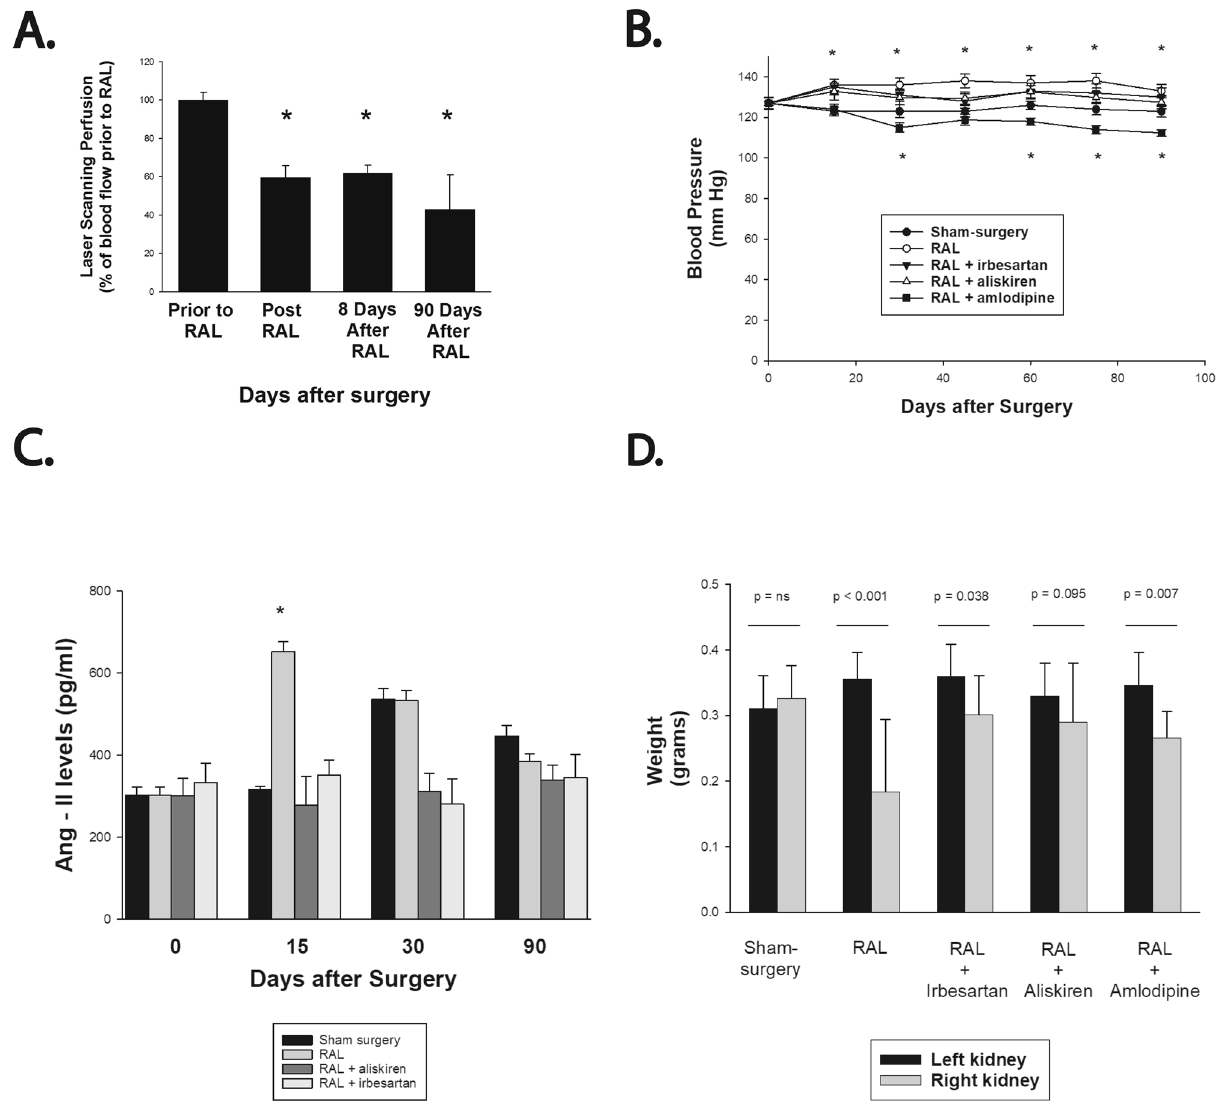
Figure 1. Renal perfusion and physiologic effects following unilateral renal artery ligation. ( A ) Laser-Doppler imaging results at different time points after RAL. ( B ) Systolic blood pressures measured on five successive days both prior to surgery and then 15, 30, 45, 60, 75 and 90 days after surgery ( C ) Plasma Ang II levels measured at various time points. ( D ) Weight (mean ± SEM) of right and left kidneys at the time of sacrifice. [* p < 0.05 compared to